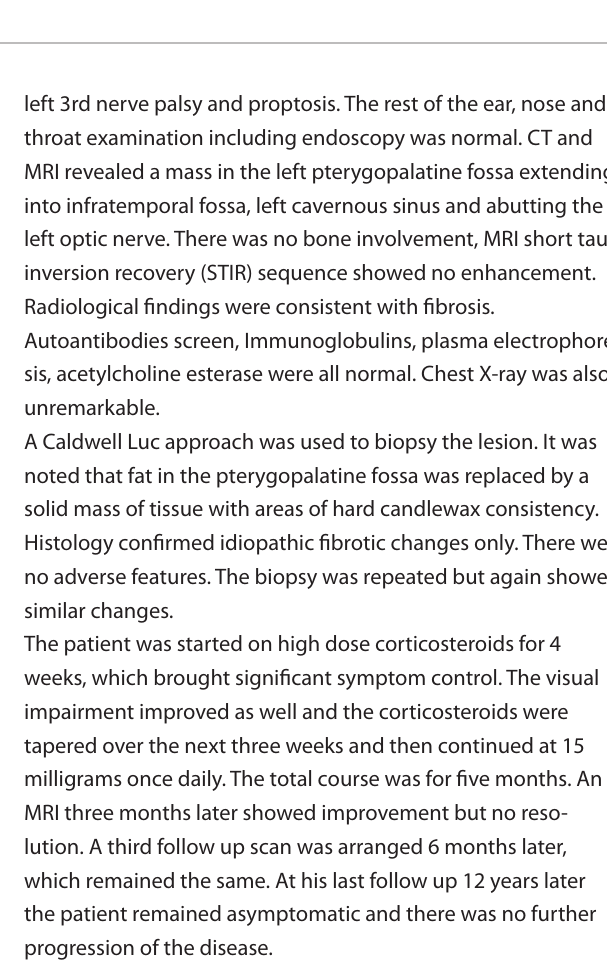
Figure 2. A. Axial CT scan showing homogeneous lesion in the left pterygopalatine fossa (black arrow). B. T1 W coronal MRI confirming hypointense lesion (Asterix) in left pterygopalatine fossa extending into left orbit. Hypointensity on T1 and T2 images helps differentiate IP from skull base neo- plasms which are characteristically iso or